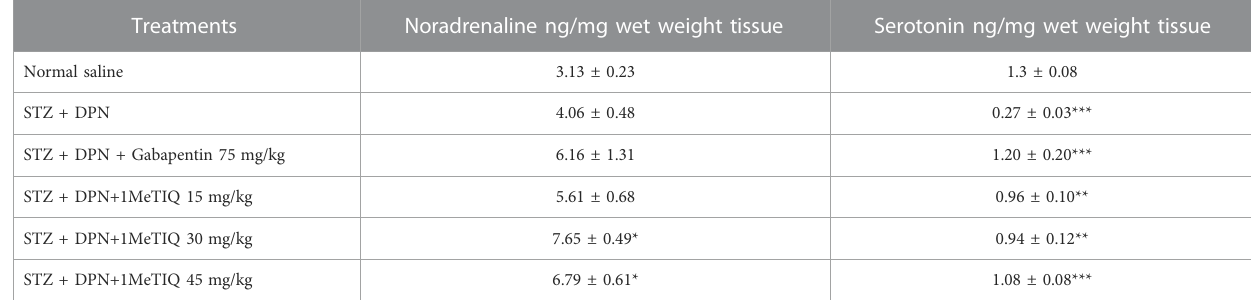
TABLE3Concentrationsofneurotransmittersinhippocampaltissueafterthestreptozotocinprotocol(i.e.,STZ+DPN)aloneorincombinationwithgabapentinor 1MeTIQ. Note: * p < 0.05, ** p < 0.01, *** p <